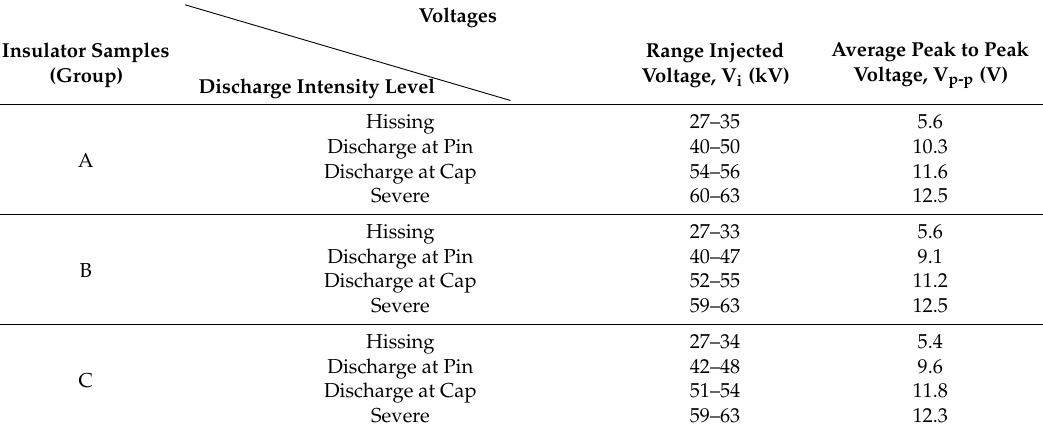
Table 7. Injected voltage and average peak-to-peak voltages of the UV signals for dry insulators conditions without